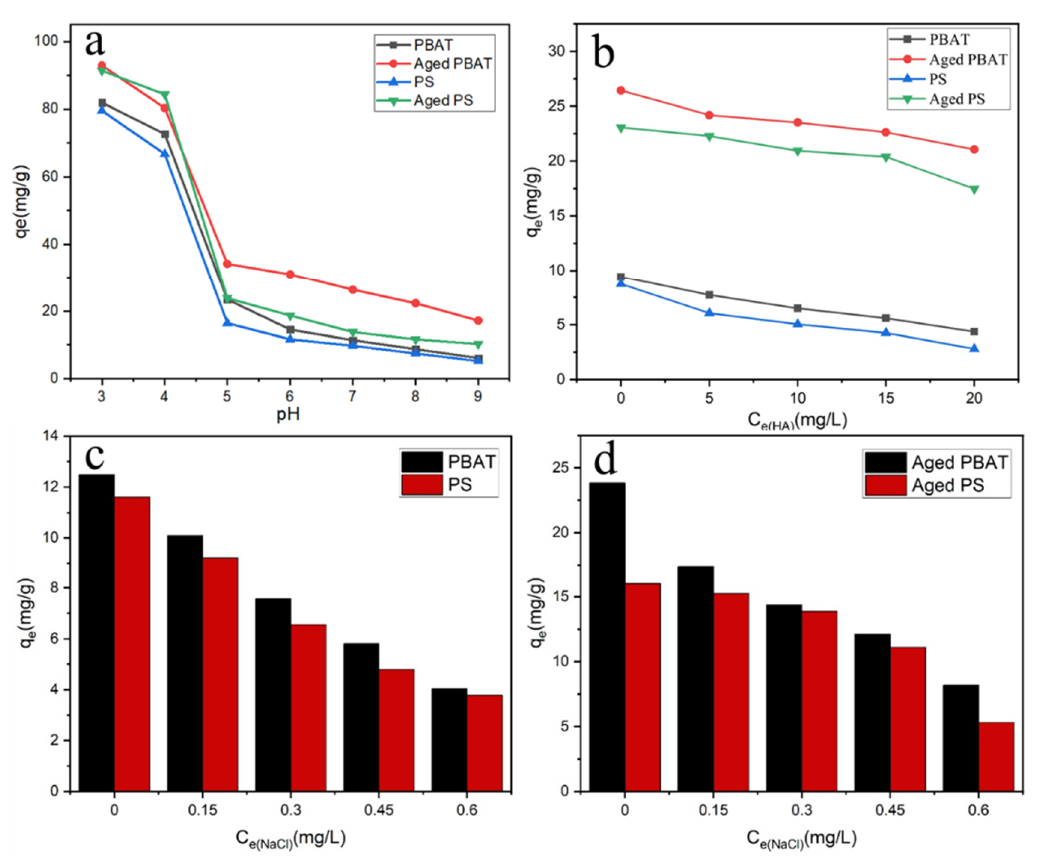
Figure 8. Effect of environmental factors on DCF adsorption by MPs (( a ) pH, ( b ) HA, ( c ) pristine MPs- salinity ( d ) aged MPs- salinity).